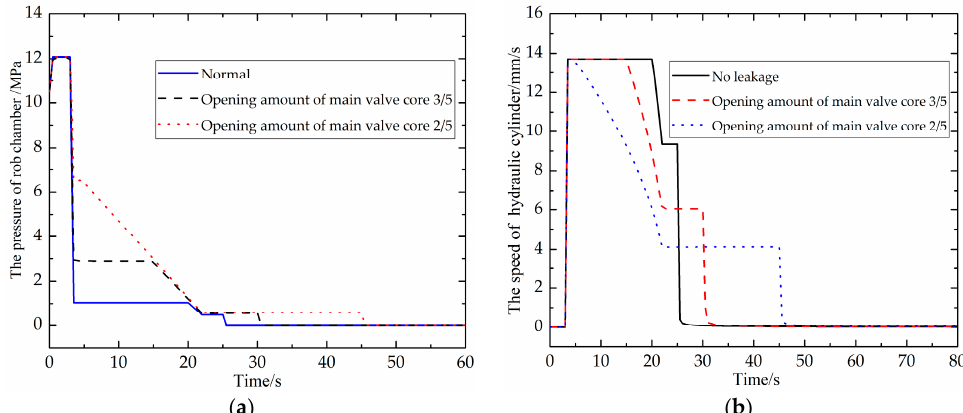
Figure 7. When the reversing valve failed. ( a ) The pressure of the rod chamber; ( b ) the speed of the hydraulic cylinder.